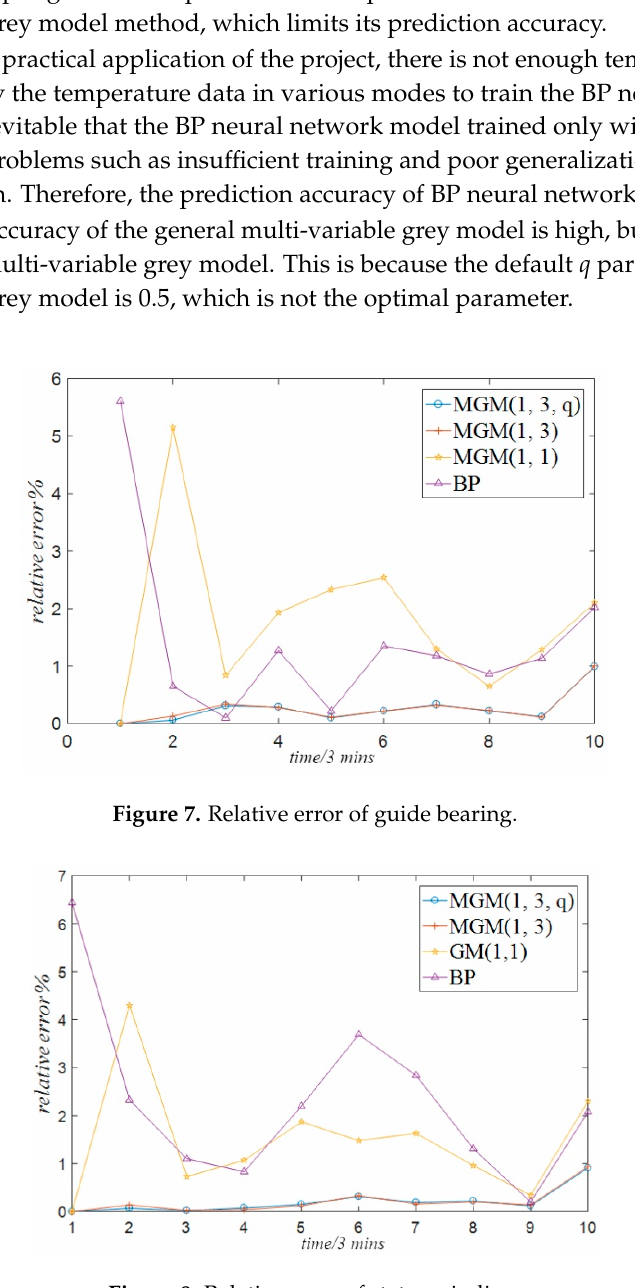
Figure 8. Relative error of stator winding.